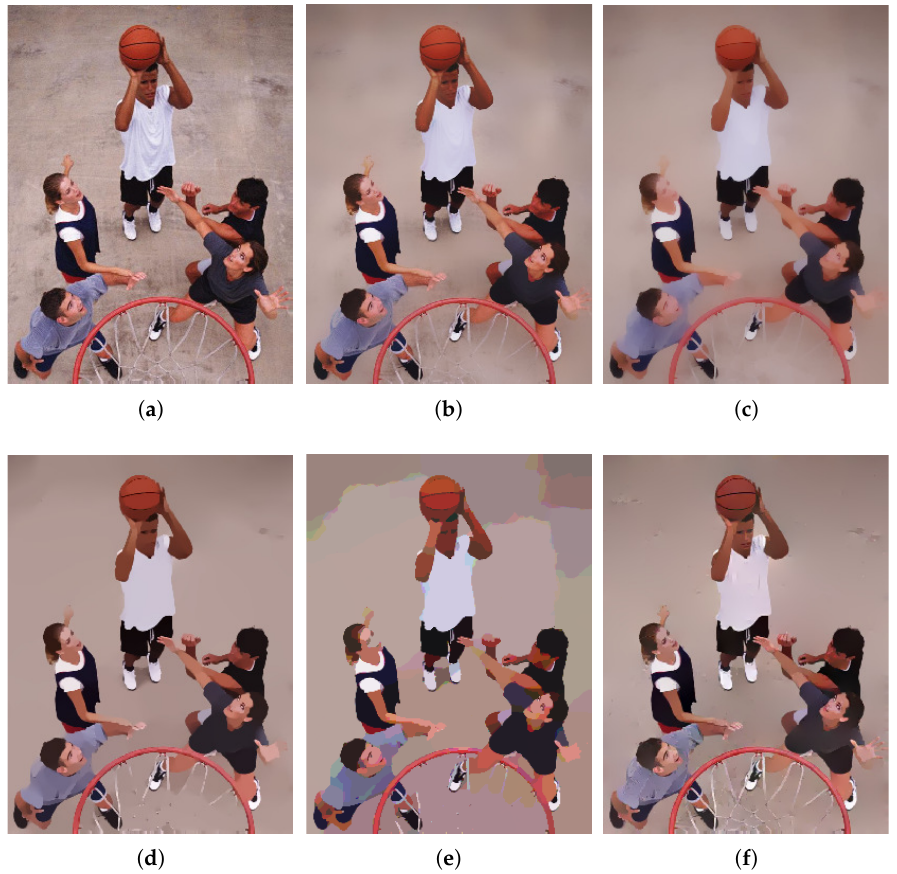
Figure 5. Comparison of our method with other methods in image abstraction. ( a ) Input; ( b ) Bilateral [18] with σ s = 8, σ r = 26; ( c ) WLS [21] with α = 1.5, λ = 0.5; ( d ) l 0 -smoothing (http://www.cse.cuhk.edu.hk/ leojia/projects/L0smoothing/ImageSmoothing.htm) [24]; ( e ) l 0 -projection [29] with α = 21749; ( f ) ours with λ = 15, σ =